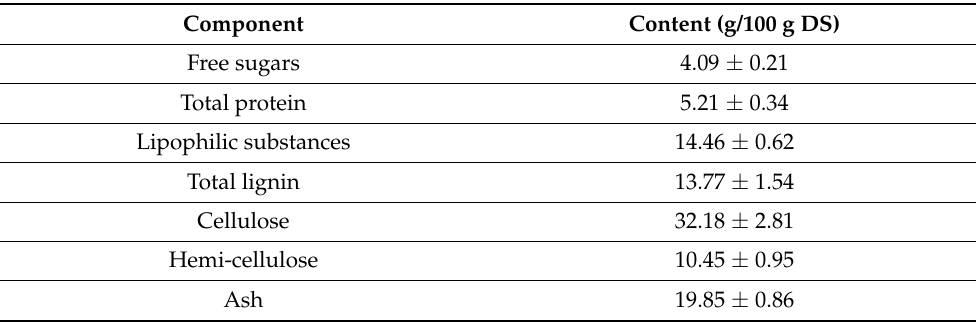
Table 3. Composition of dry SMS (spent mushroom substrate) of P. ostreatus cultivation. The presented results are the mean of two independent SMS